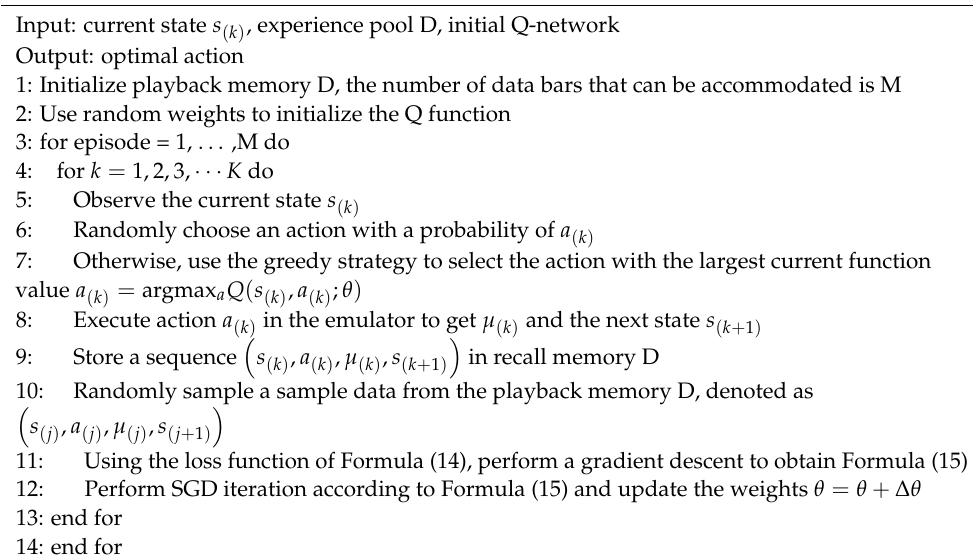
Algorithm 1 Based on DRL offloading